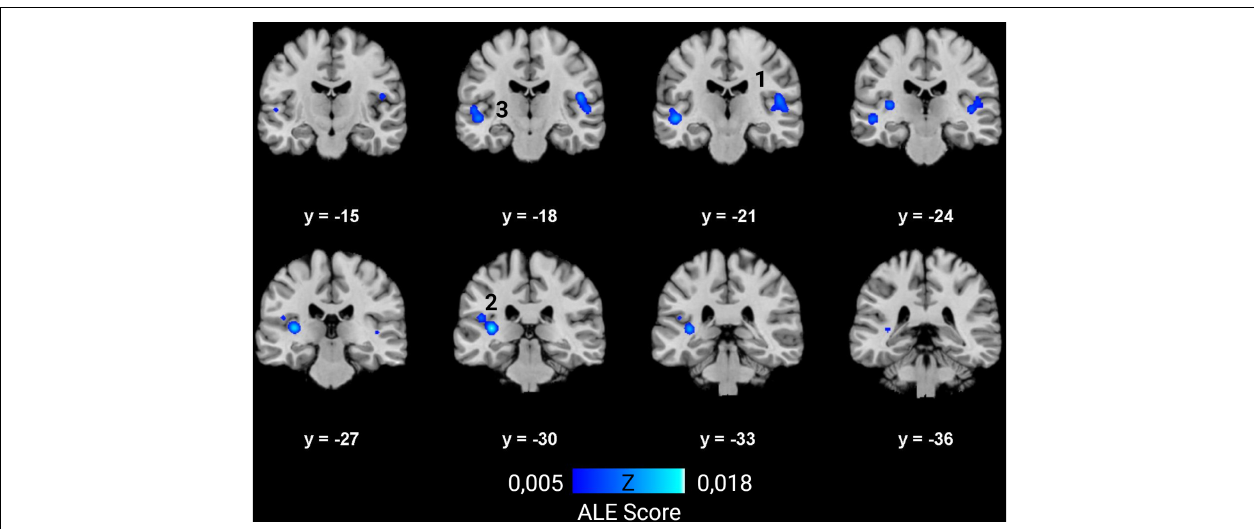
FIGURE 7 | ALE meta-analysis of changes in GM and WM density in the deaf brain. Right hemisphere is shown on the right in the images. The numbers on top of the slices show the y -coordinates of the coronal slices in MNI space. Three clusters of decreased volume in deaf were found significant, and none of increased volume ( p < 0.01, cluster-level family-wise error p < 0,05). They are situated in both STG and adjacent middle temporal gyrus and insula, and involve mainly WM. The numbers correspond to those indicated in Table 1 . TABLE 1 | Characteristics of the clusters from the ALE meta-analysis showing decreased volume in deaf subjects. Clusters Location Tissue type Related BA Coordinates of the center Size (mm 3 (relative weight) (MNI)